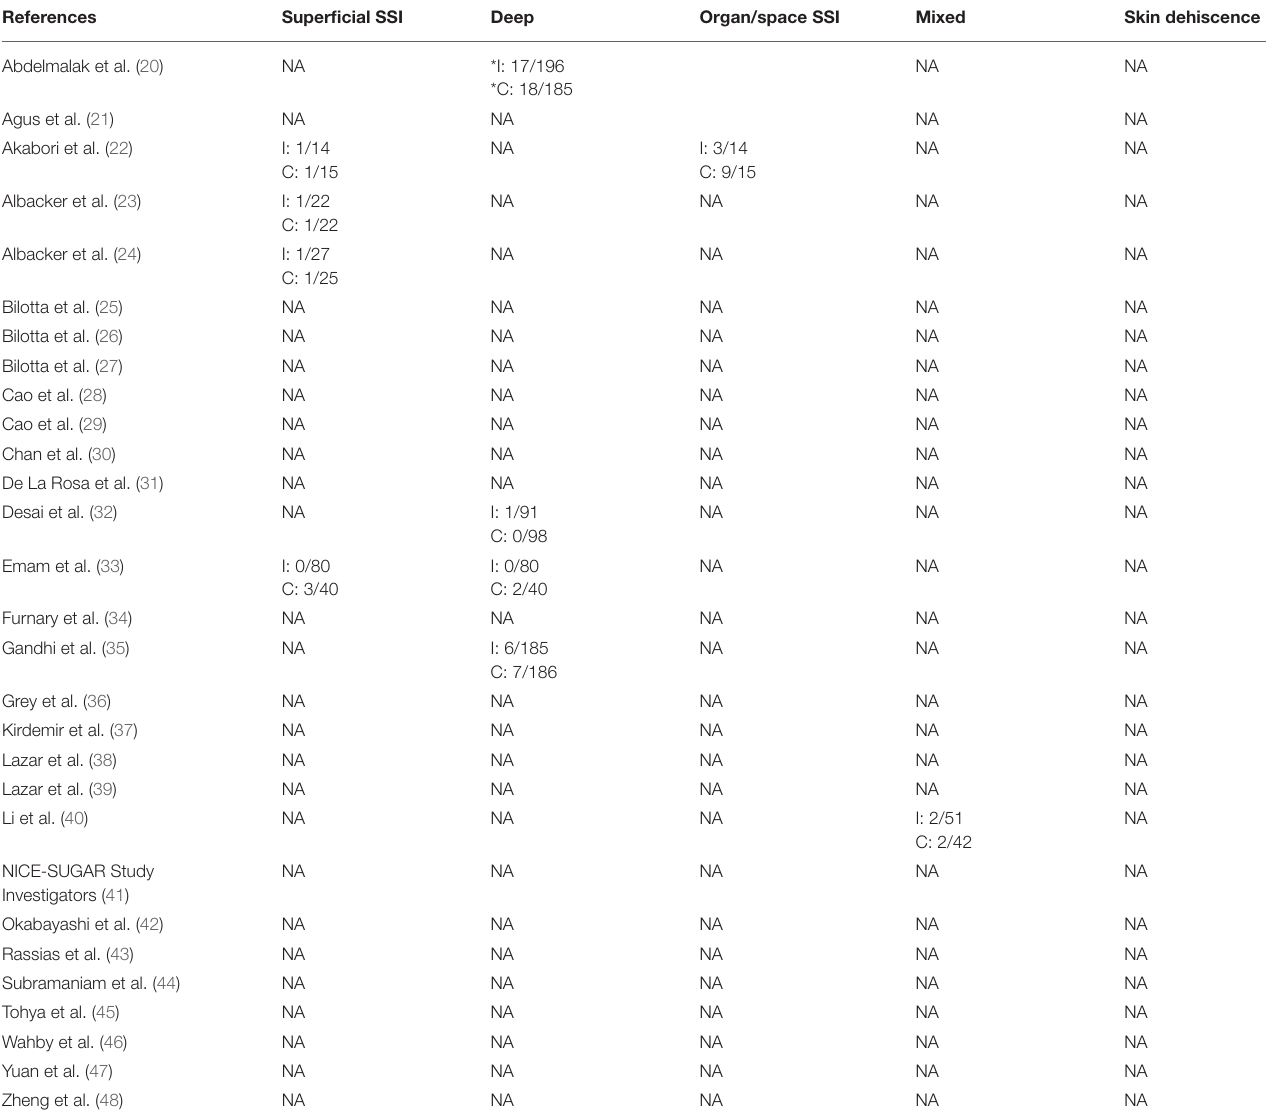
TABLE 4 | Proportion of different type of SSI in the included